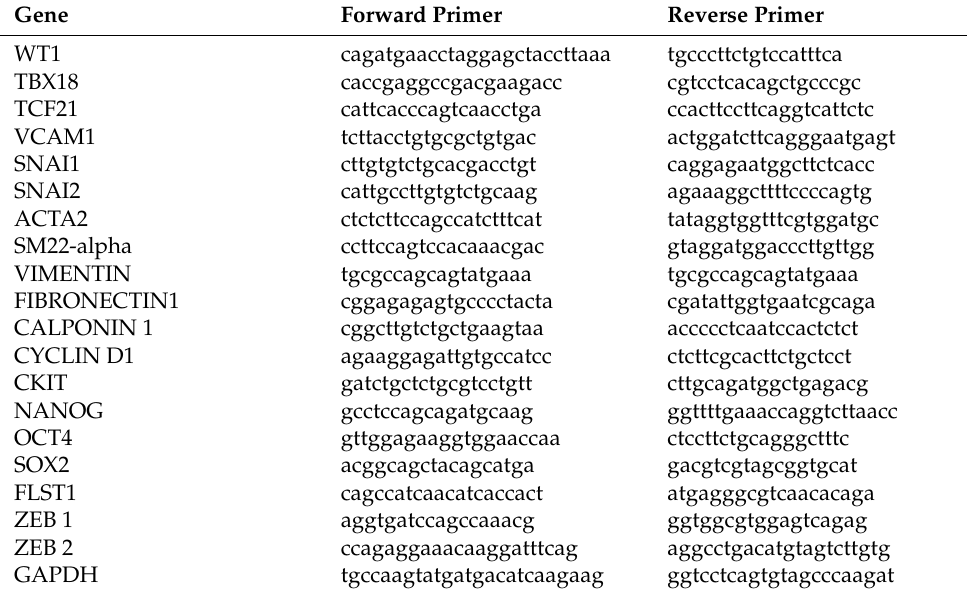
Table 1. List of primers used in this